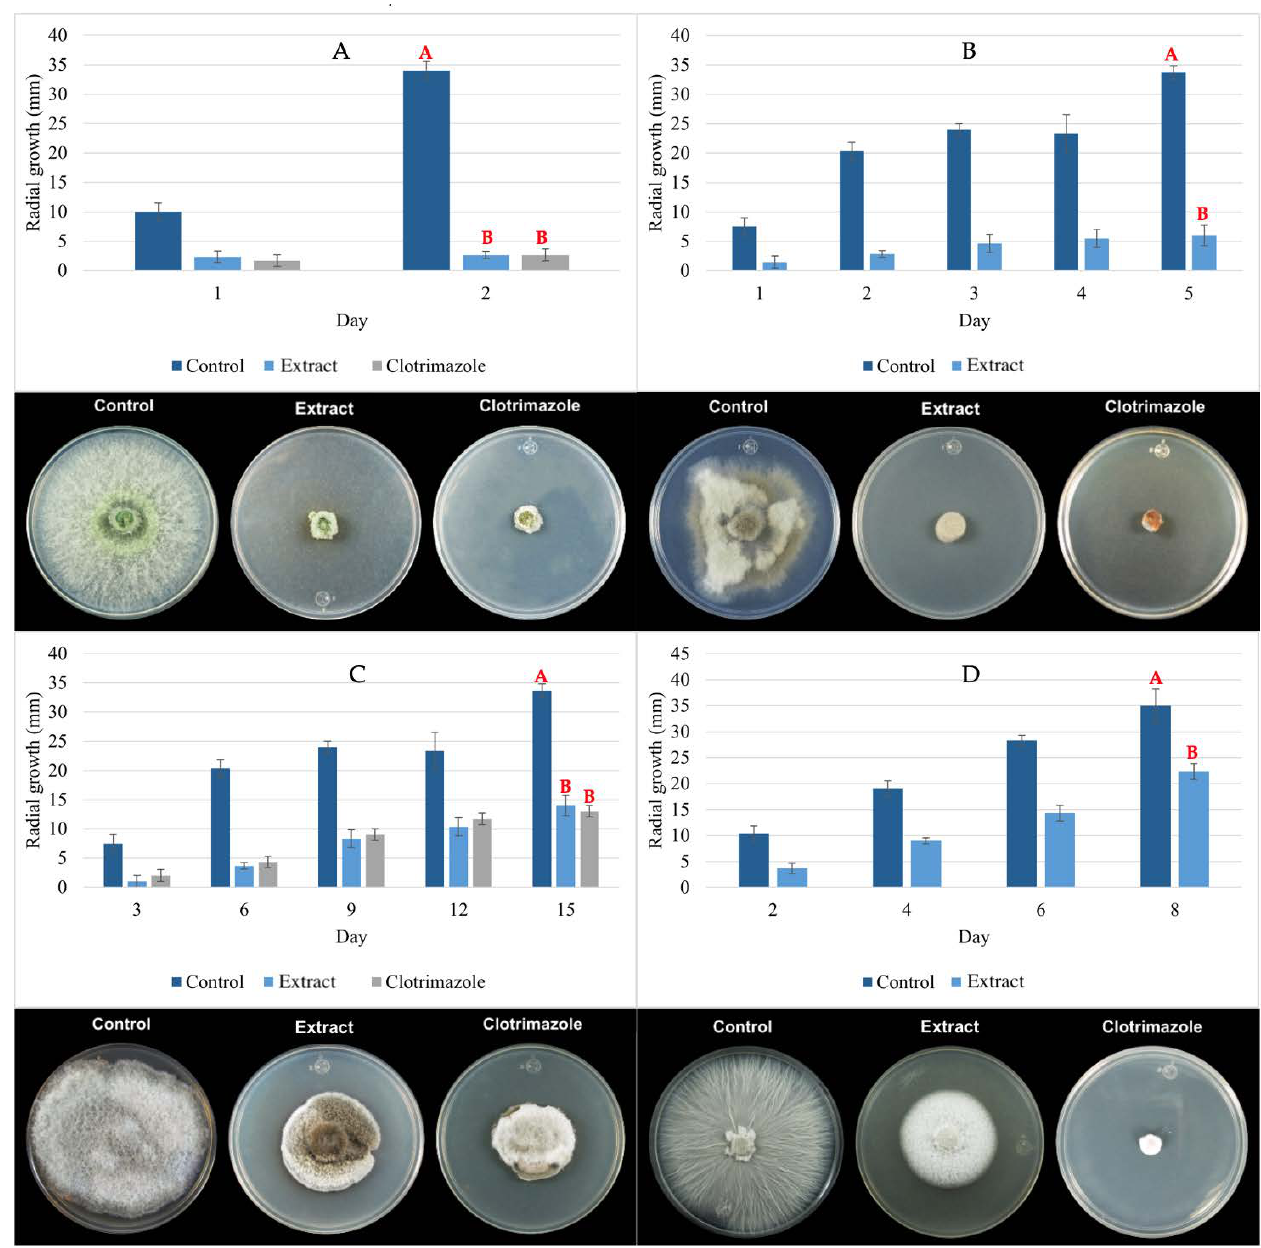
Figure 5. Inhibition effect of P aib against mycelial growth of ( A ) C. gloeosporioides; ( B ) B. cinerea; ( C ) A. alternata and ( D ) F. oxysporum on PDA media after treatment with 800 µg mL −1 of P aib extract. Different letters represent significant differences between treatments.